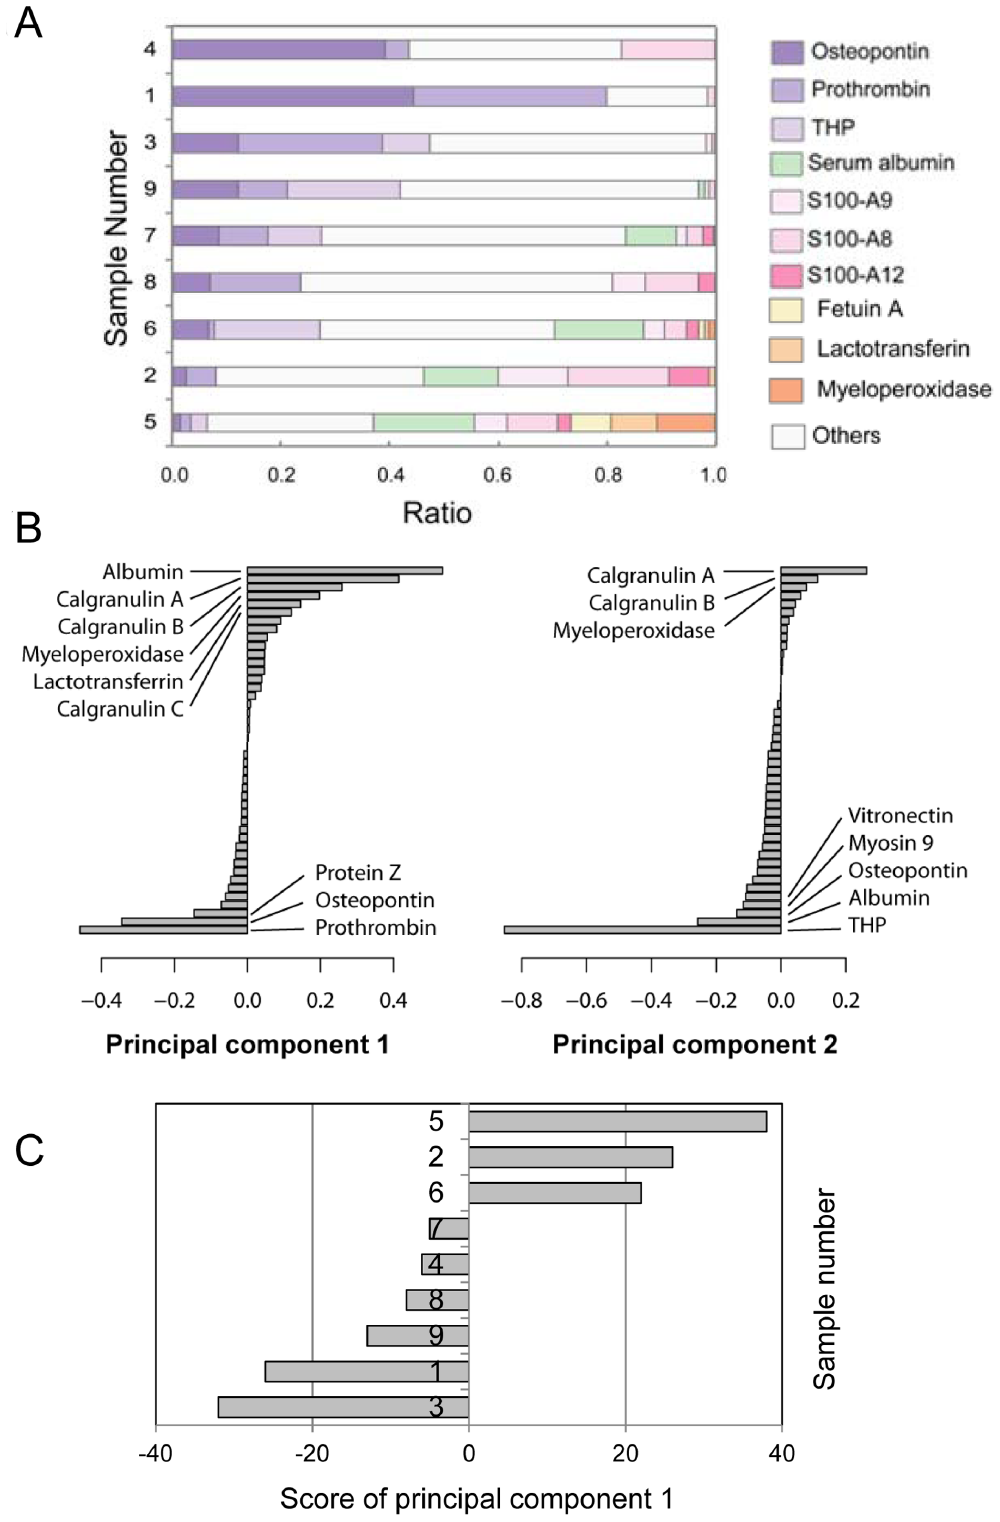
Figure 5. Comparison of relative peptide numbers detected of individual CaOx kidney stones. (A) After nano-LC/MALDI-MS/MS analysis, the numbers of peptide hits were presented as a bar graph with the total number of peptide hits in each gel sample as 100%. (B) The numbers of peptide hits were subjected to principal component analysis, and the first (left) and the second (right) eigenvectors were shown in a decreasing order. (C) The score of principal component 1 of each sample was presented as a bar graph.